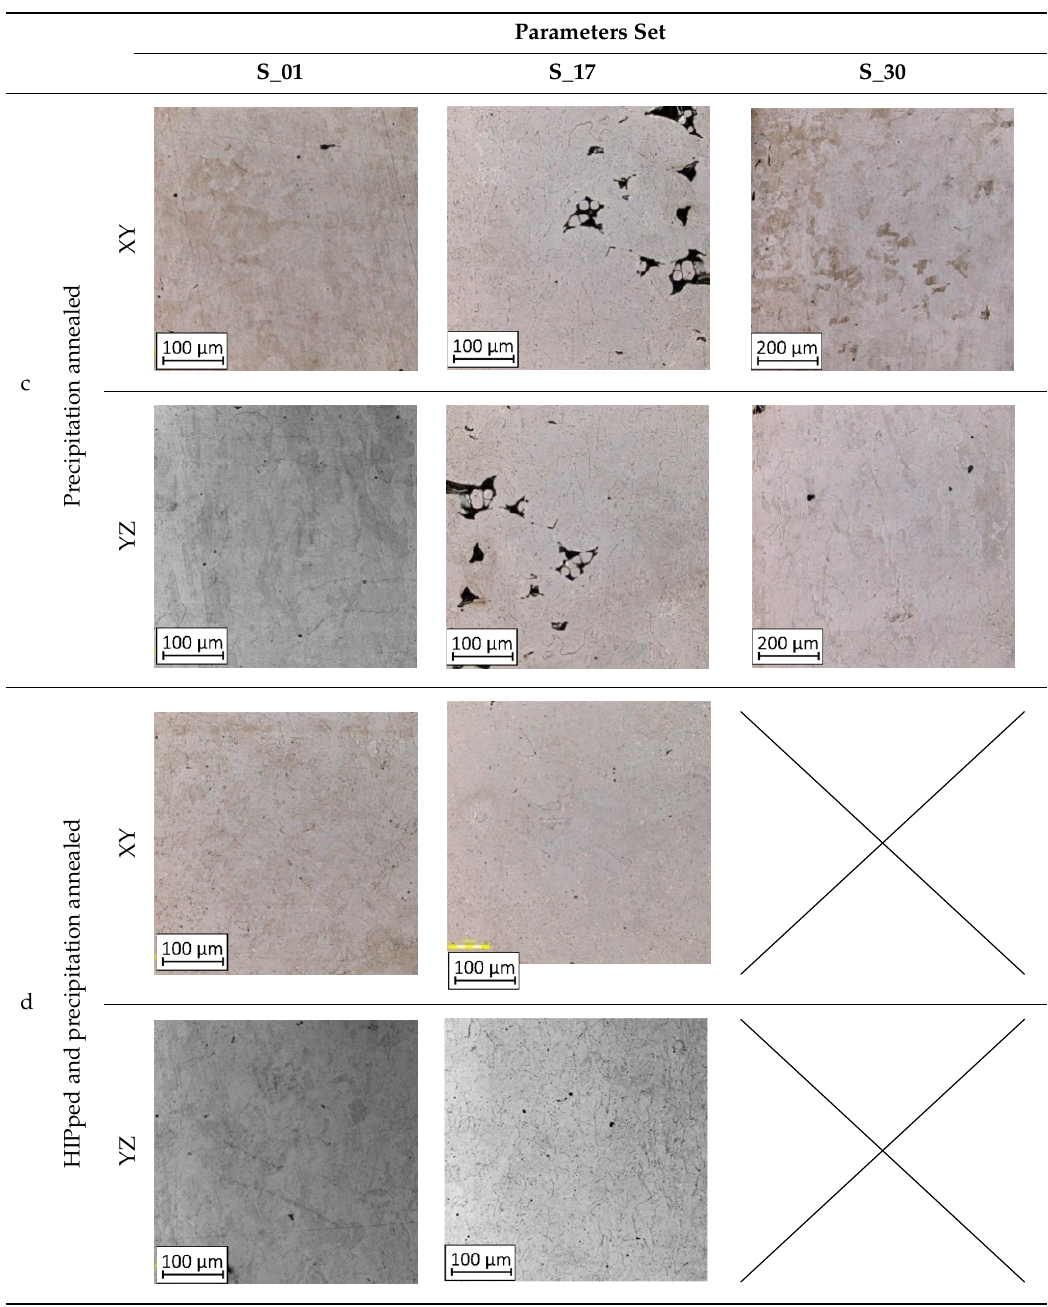
Table 4. Microstructure of S_01; S_17 and S_30 samples heat treated using different processes and their combinations.